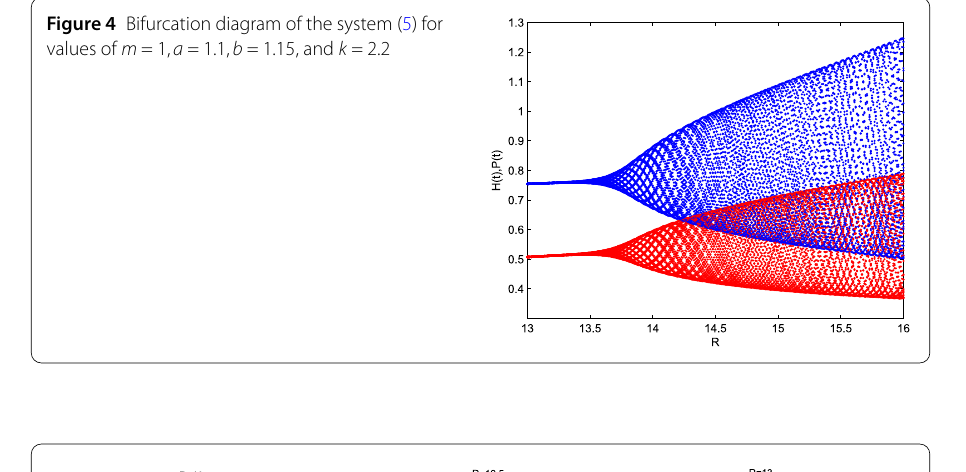
Now, the coefficient a (0), which determines the direction of the appearance of the invari- ant curve in a generic system exhibiting a Neimark–Sacker bifurcation, can be computed via